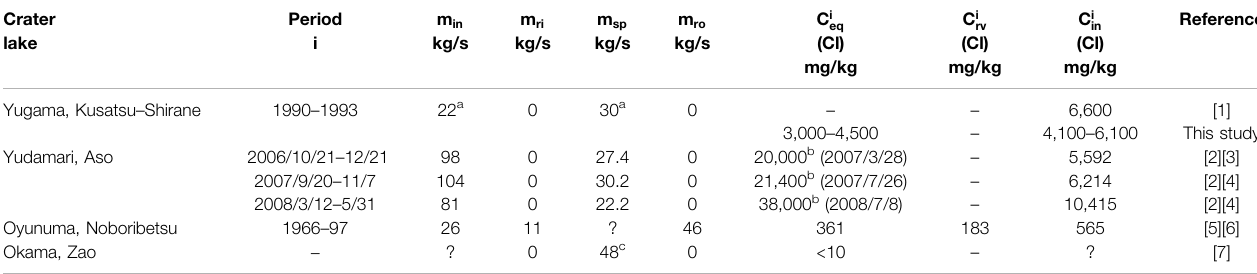
TABLE 3| SummaryoftheCl concentrationsofthebulk hydrothermal fl uid injected from subaqueous fumaroles and hotsprings C i in inthe period ofinterest i . Inthecases of YugamaandYudamaricraterlakes, C i in werecalculatedfrom Eq.3 ,basedon m in , m sp ,and C i eq .ForOyunumacraterlake, C i in wascalculatedfrom Eq.16 ,using m rv and C i rv , in addition to m in , m sp , and C i eq . The C i eq for Yugama crater lake was obtained from this study. C i eq for Yudamari and Oyunuma crater lakes are the Cl concentrations of the lake water assuming steady-state conditions. Numbers refer to the following references: [1] Ohba et al. (1994), [2] Terada et al. (2012), [3] Miyabuchi and Terada (2009), [4] Shinohara et al. (2015), [5] Murozumi et al. (1966), [6] Fukutomi et al. (1968), and [7] Kato